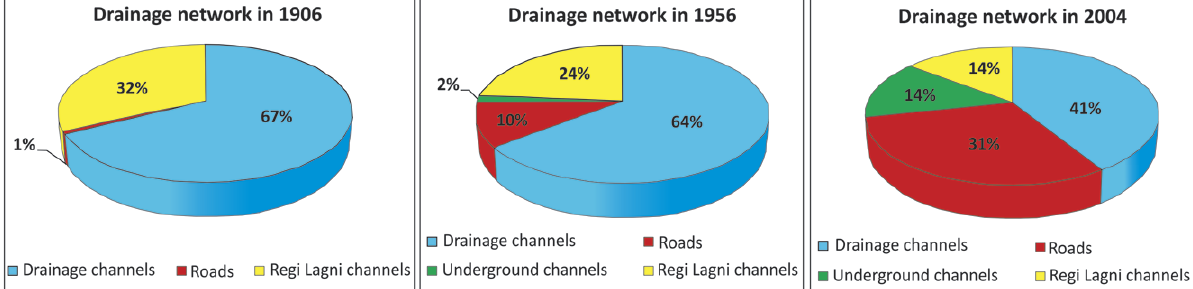
Figure 14. Hydrographical network modifications from 1906 to 2004 for the study area.